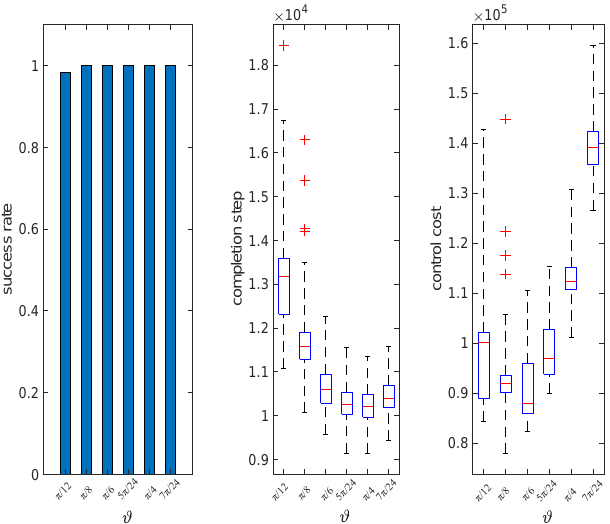
Figure 17. The algorithm performance with respect to the variations of ϑ . The algorithm performance with respect to the variations of r is shown in Figure 18. r determines when the sheepdog should pause. For large r , the sheepdog pauses even if it is still quite far from the sheep herd, which greatly reduces the efficiency of the herding algorithm and also leads to a rather low success rate. If we reduce r , then the sheepdog pause less, which, on the one hand, makes herding faster, and on the other hand, increases the control